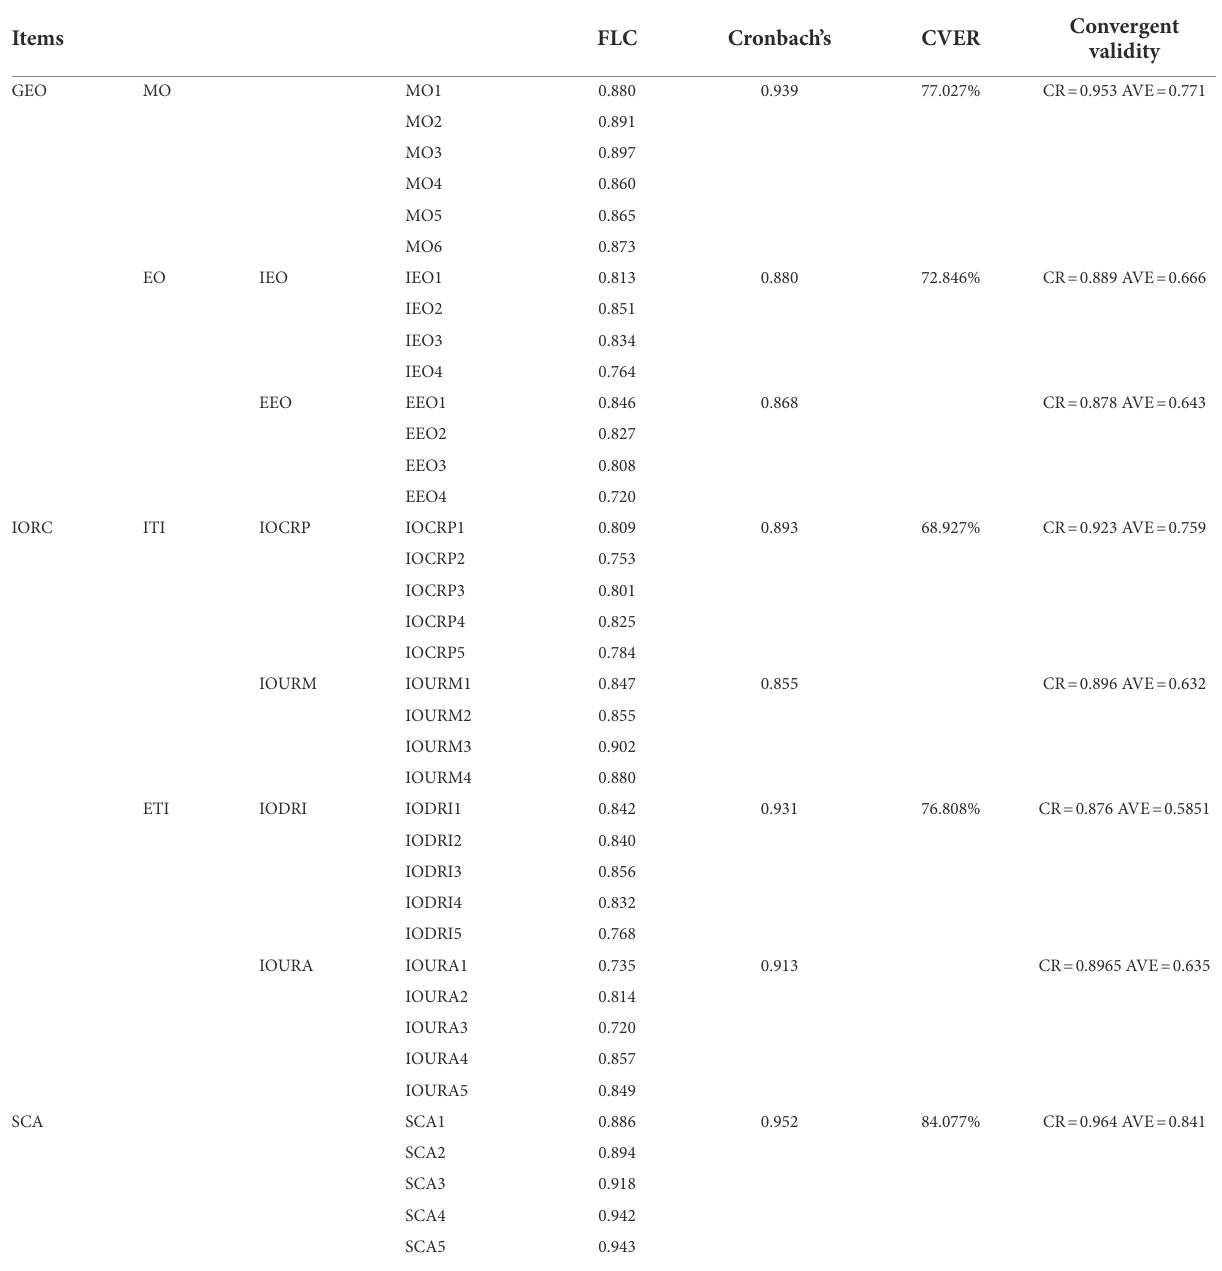
TABLE 3 Results of the reliability and validity test.